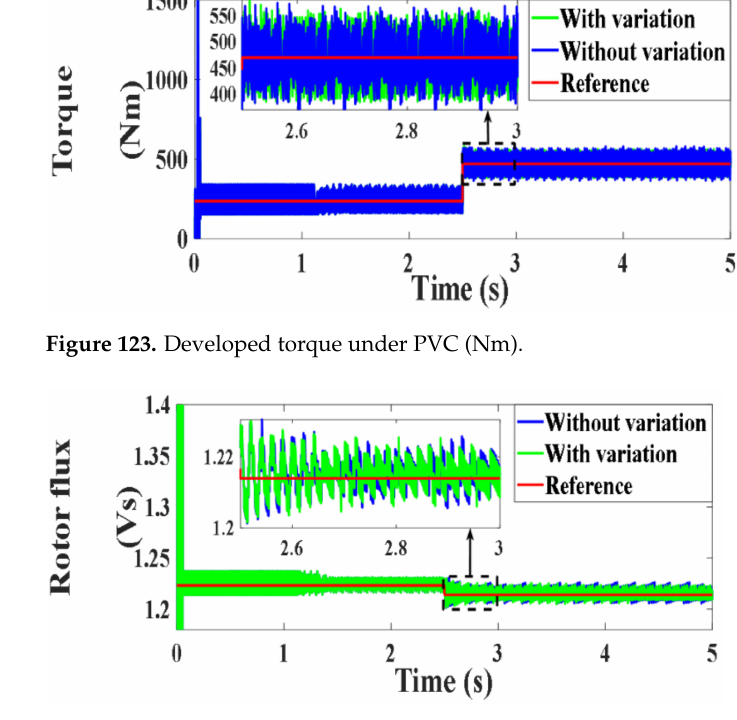
Figure 124. Rotor flux under PVC